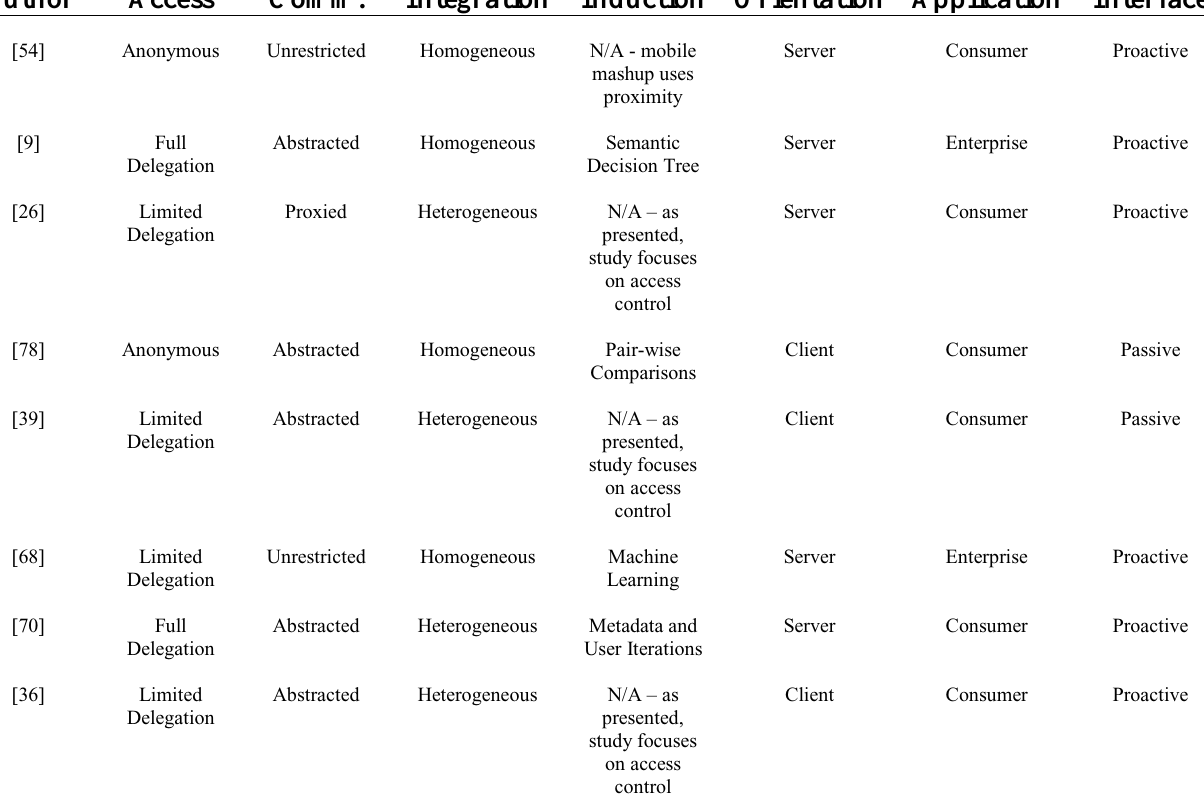
Table 6. Mashup Classification Framework (applied to